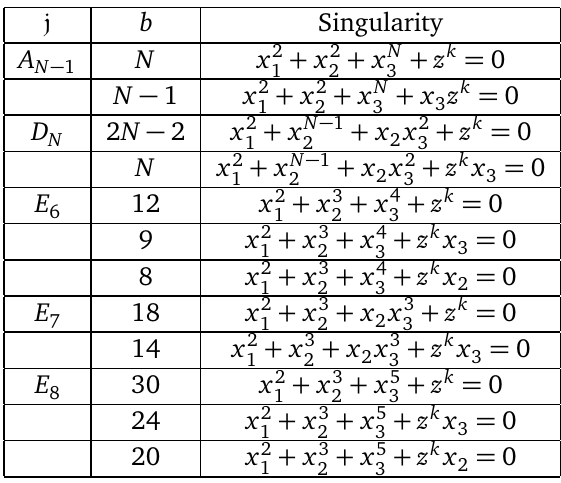
Table 1: Three-fold isolated quasi-homogenous singularities of cDV type correspond- ing to the J ( b ) [ k ] irregular punctures of the regular-semisimple type in [ 59 ] . These 3d singularity is very useful in extracting the Coulomb branch spectrum [ 85 ]